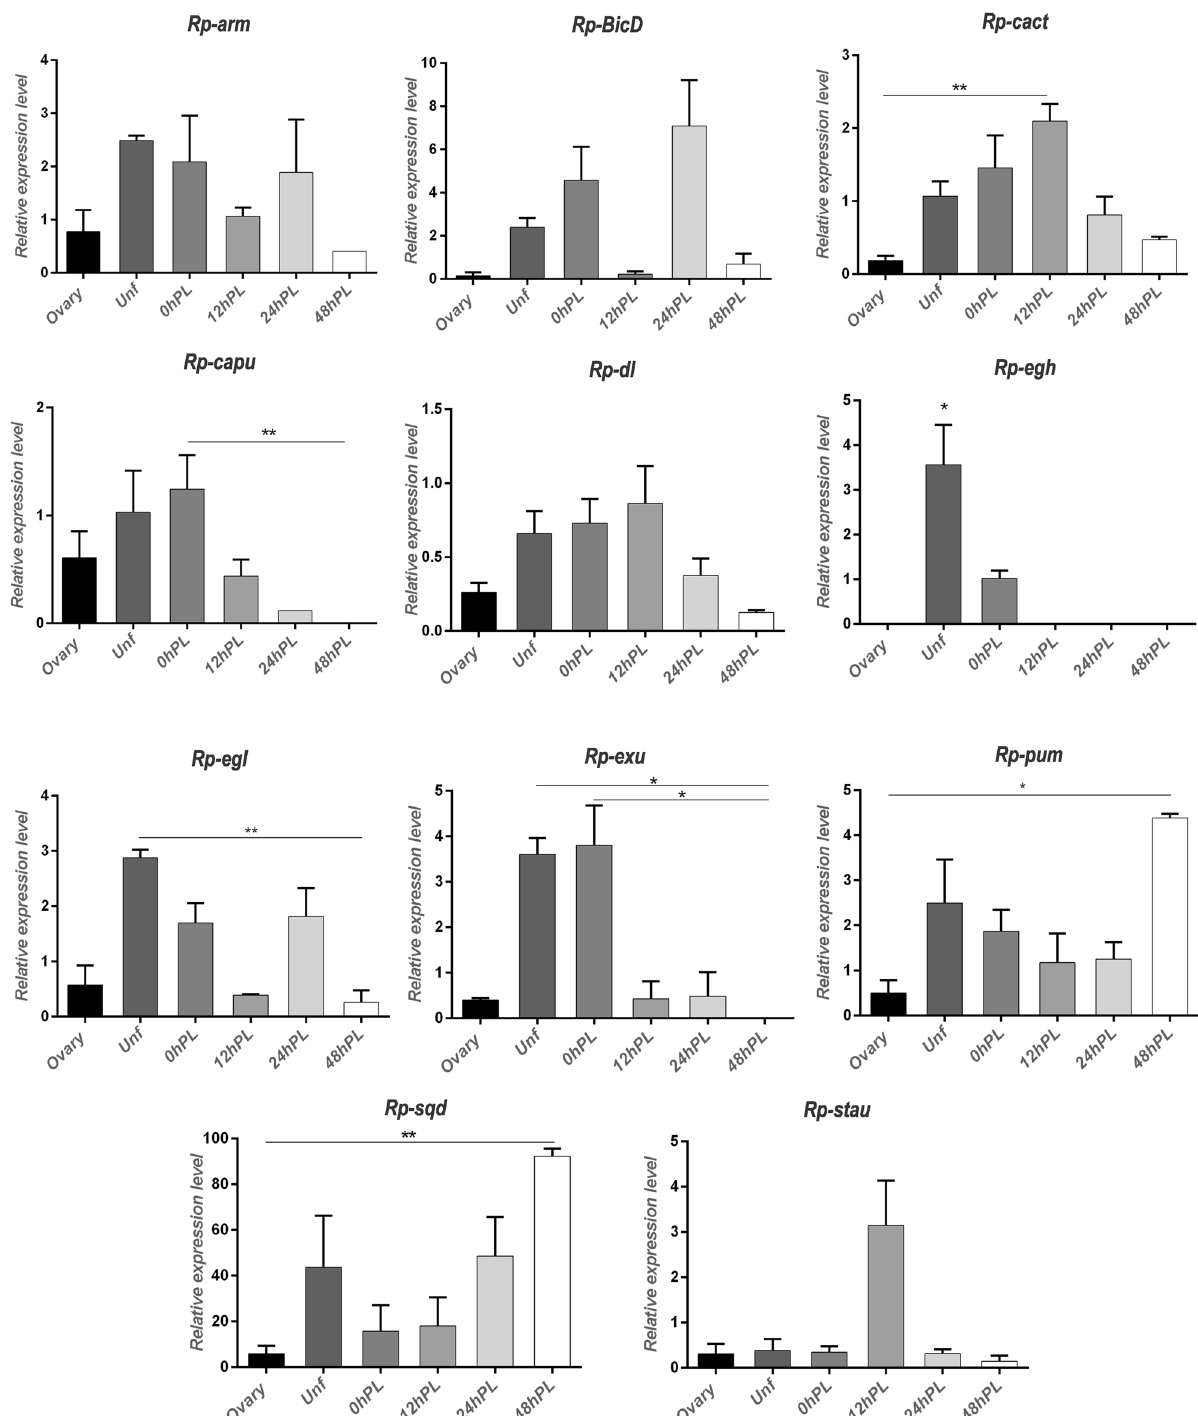
Figure 4. Real-time quantitative PCR of expression of candidate genes in the different stages. X axis: developmental times analyzed. Y axis: expression relative to the reference gene. Values are expressed as mean ± SEM of 3 independent experiments. Rp-arm : Armadillo ; Rp-BicD: Bicaudal D ; Rp-cact: Cactus ; Rp-capu: Cappuccino ; Rp-dl: Dorsal ; Rp-egh: Egghead ; Rp-egl: Egalitarian ; Rp-exu: Exuperantia ; Rp-pb: Proboscipedia ; Rp-pum: Pumilio ; Rp-sqd: Squid ; Rp-stau: Staufen . Graphs were performed using GraphPad Prism 7. * < 0.1; ** <